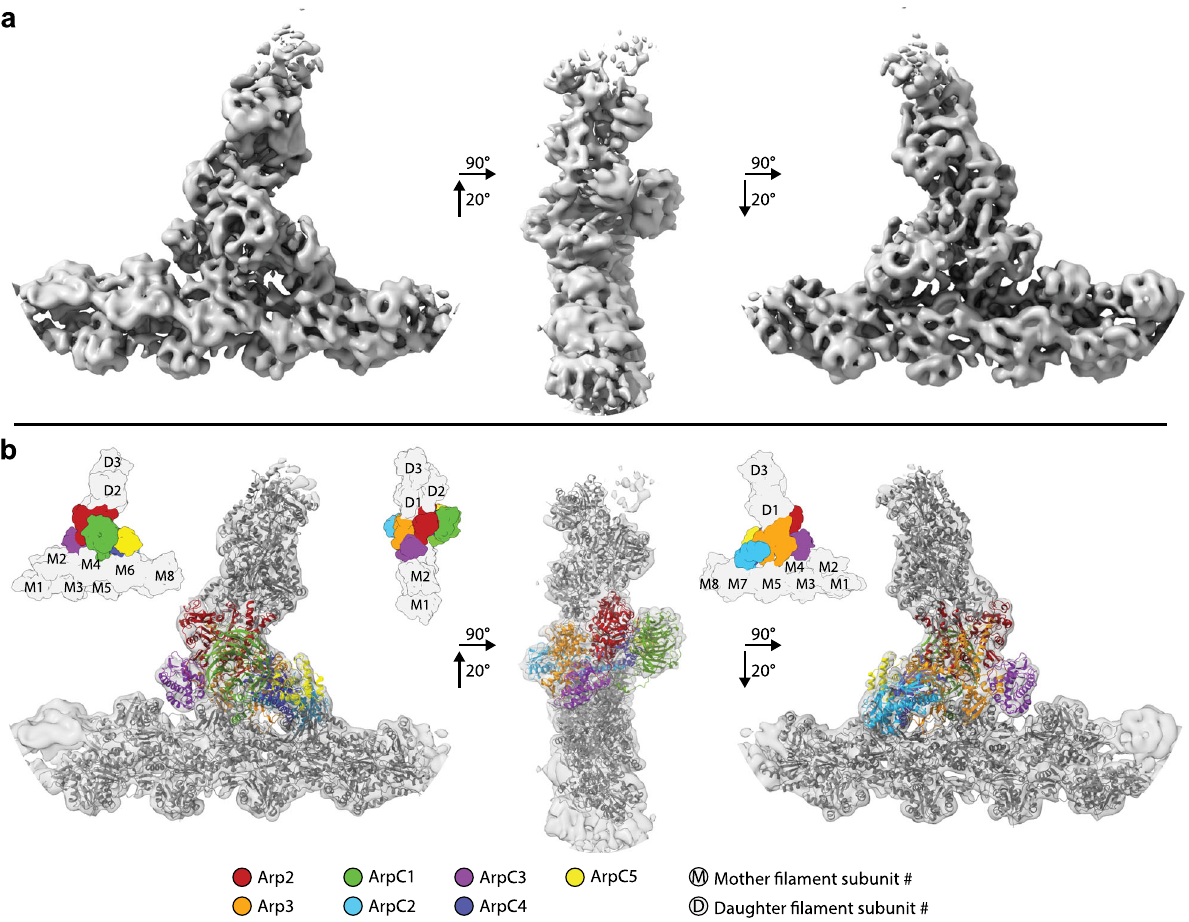
Fig. 1 Subnanometer structure of the actin fi lament Arp2/3 complex branch junction in cells. a Isosurface representation of the actin fi lament Arp2/3 complex branch junction in cells at 9 Å resolution. The structure is shown from three orientations. A guide for orientation is given in b . b The electron microscopy density map (shown transparent) with the fl exibly fi tted models of the Arp2/3 complex subunits and actin fi laments. Schematic guides indicate the positions of the individual subunits of the complex, and the actin subunits of both the mother (M#) and daughter fi laments (D#). Subunit colors are annotated in the fi gure with Arp2 being red, Arp3 orange, ArpC1 green, ArpC2 light blue, ArpC3 violet, ArpC4 dark blue, and ArpC5 yellow. Actin is shown in gray. The color code and legend are used throughout the manuscript to aid the